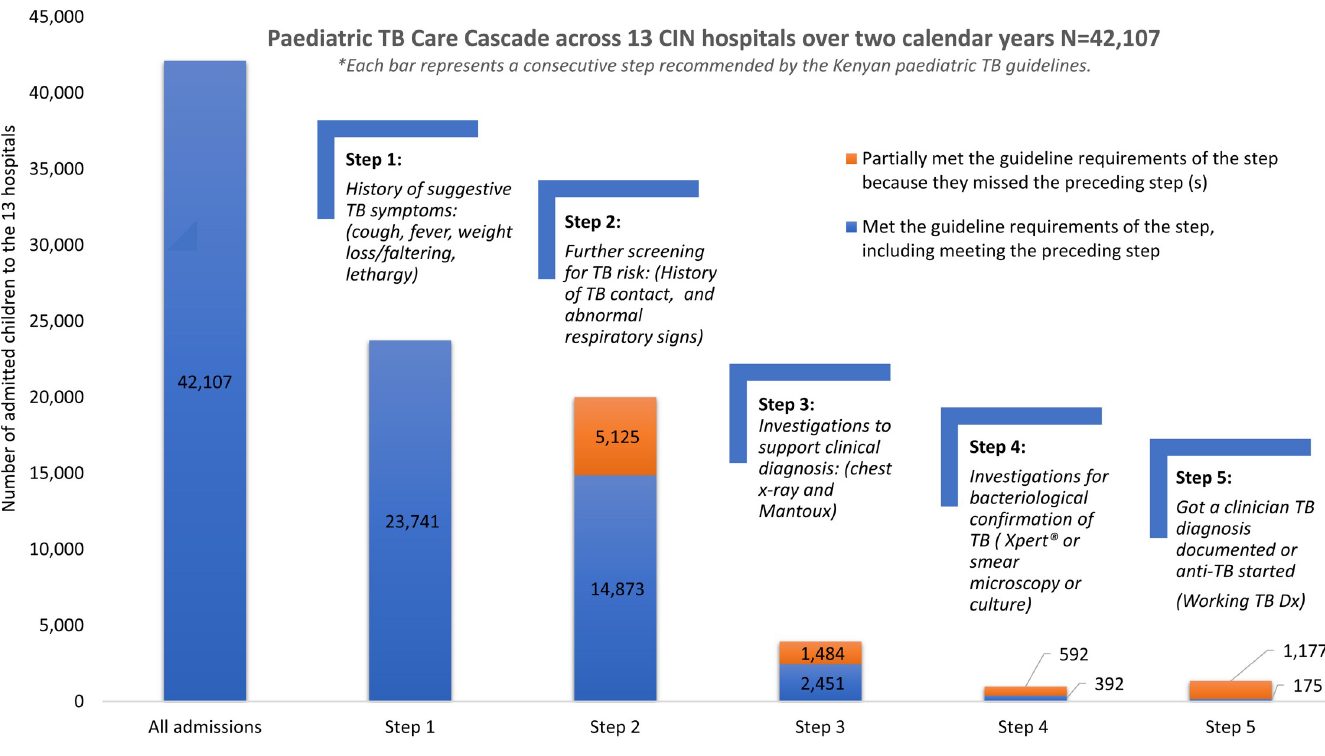
Fig 3. Paediatric TB Care Cascade across the 13